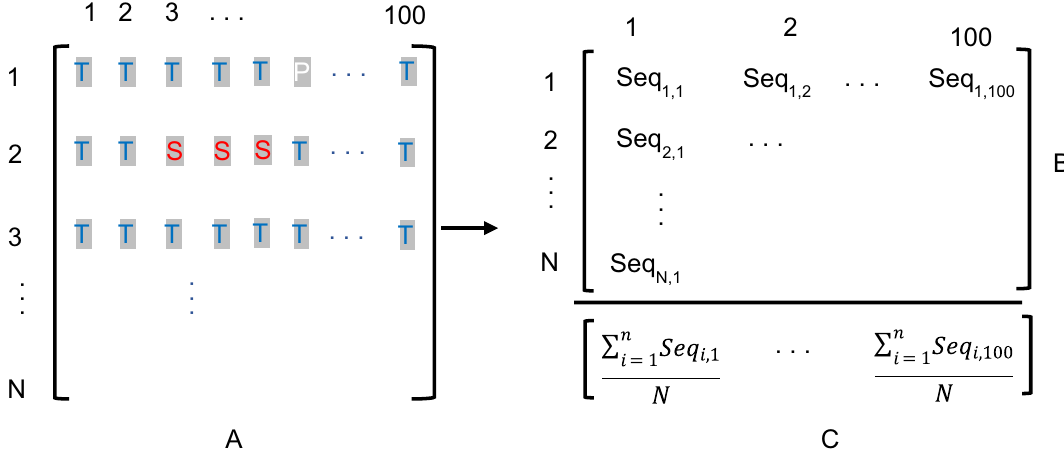
Figure 3. Gaze object sequence calculation procedure. In matrix A, “T” indicates gazes on the target area, “P” indicates gazes on the path area, and “S” indicates gazes on the avoidance margin area. The colors in the figure correspond to the color-coded objects (Blue: Target, White: Path, and Red: Avoidance Margin). Each raw gaze object sequence was represented by a (1 × 100) set of frames. In the first line of this example, the gaze object transitioned from the target to path and then to the target. “N” indicates number of trials in each avoidance margin condition. Matrix B shows a convert matrix. We scaled the result to integer numbers (e.g., “2” indicates target area, “5” indicates path, and “10” indicates avoidance margin). Matrix C shows average